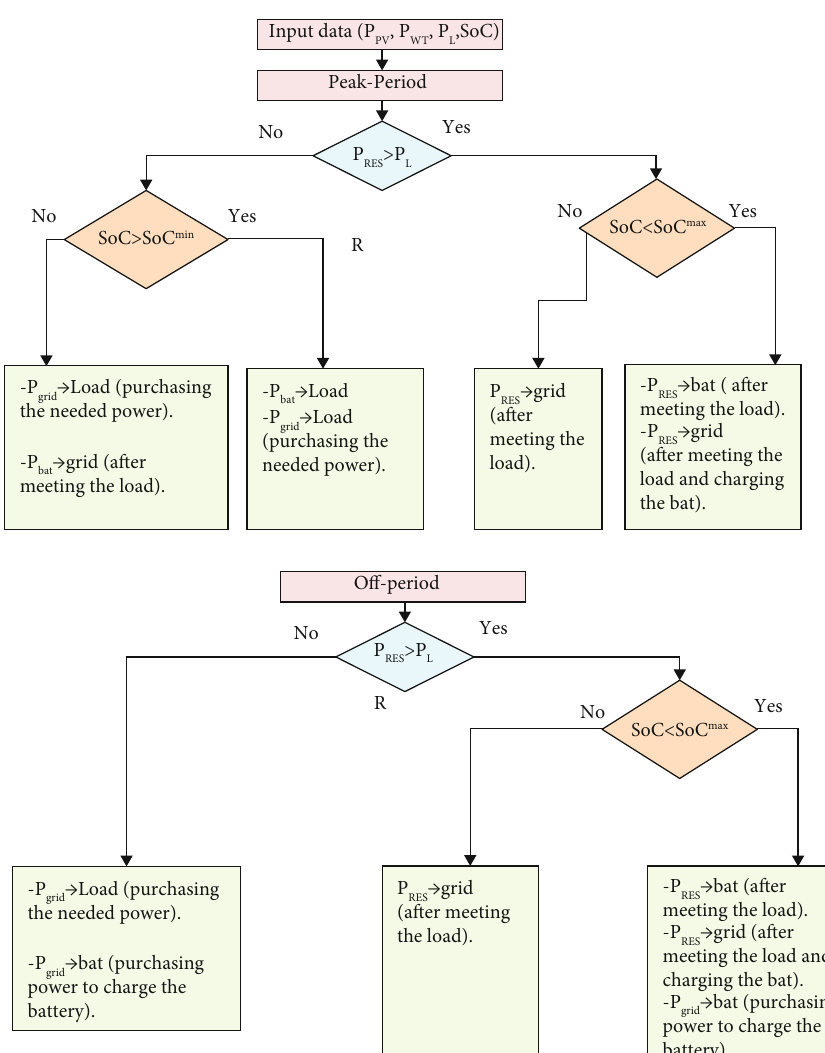
Figure 4: Flow chart of EMS: ToU